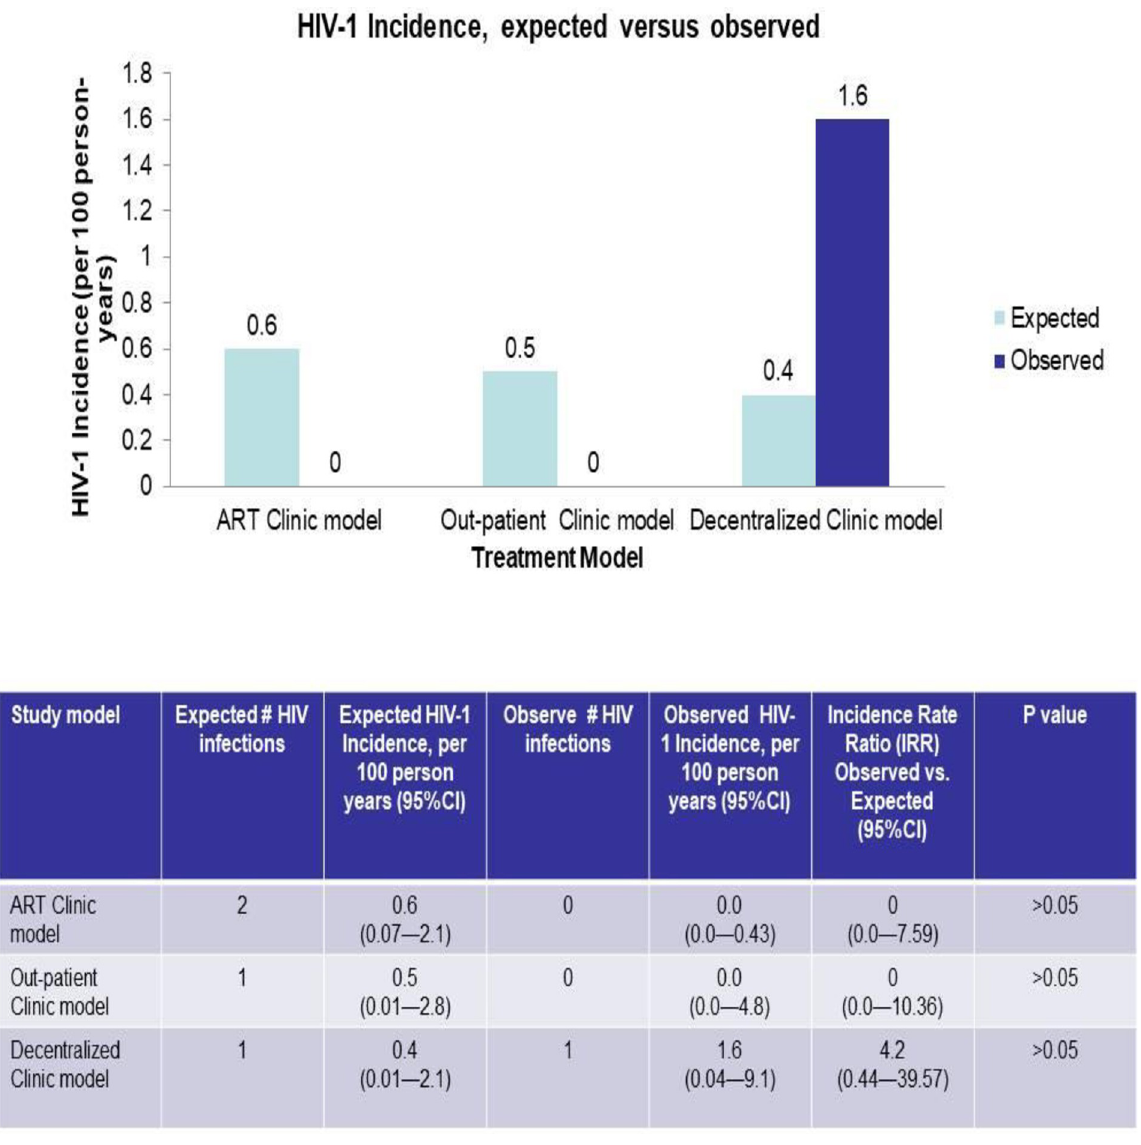
Fig 3. HIV-1 Incidence expected versus observed by PrEP